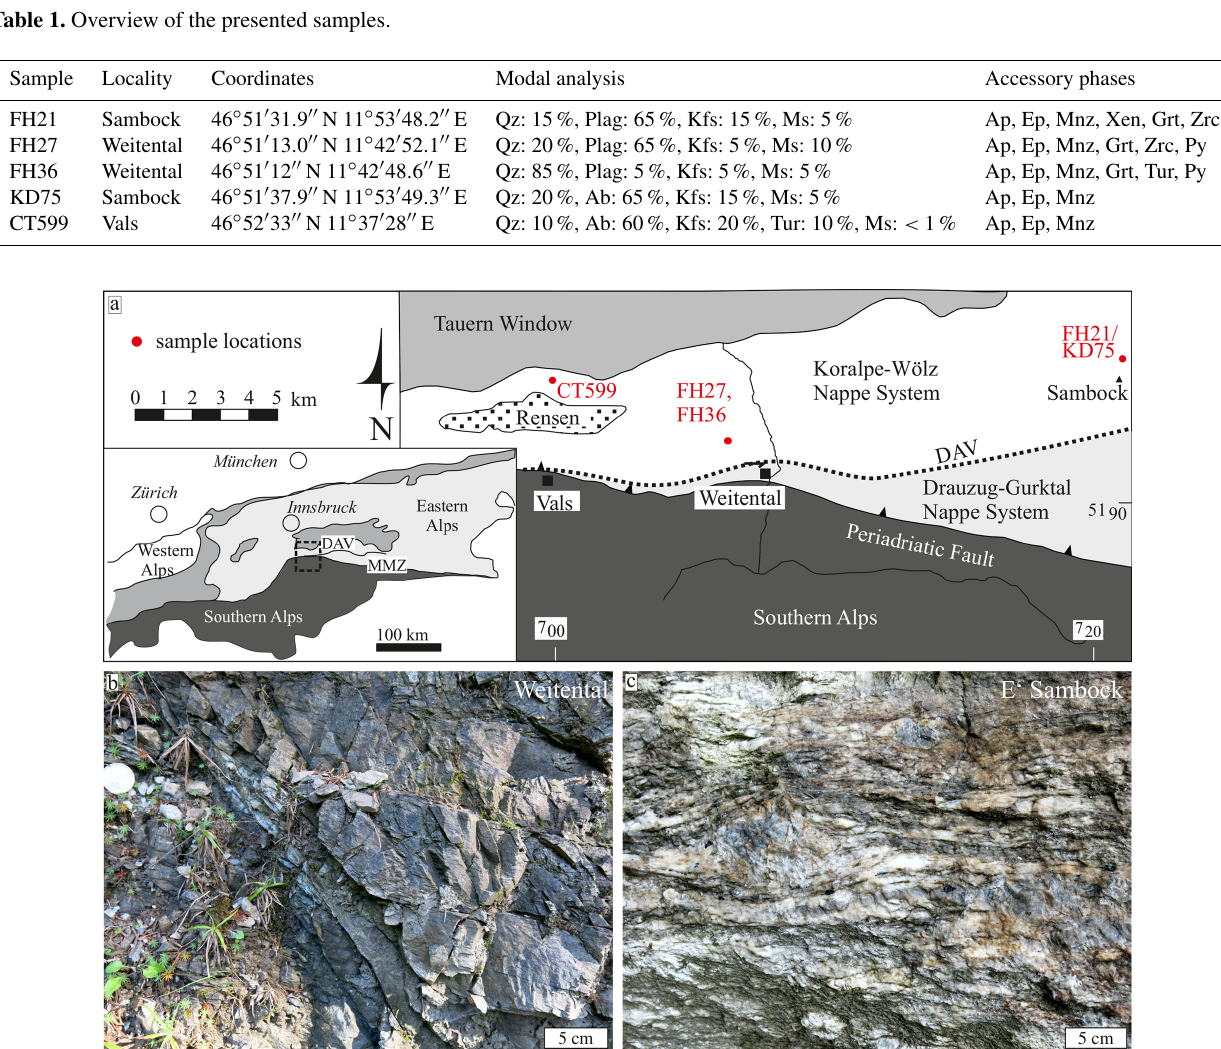
Figure 1. Simplified geological map of the study area. Investigated samples are highlighted in red (modified after Stöckhert, 1987). (b, c) Field photographs from the pegmatite occurring near Weitental (FH36) and at the crest east of Sambock